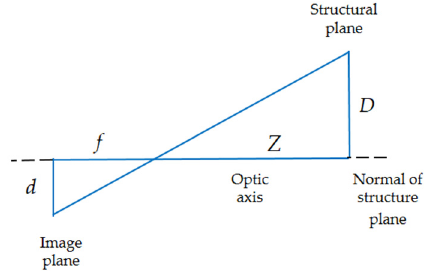
Figure 8. Calculation diagram of scale factor.